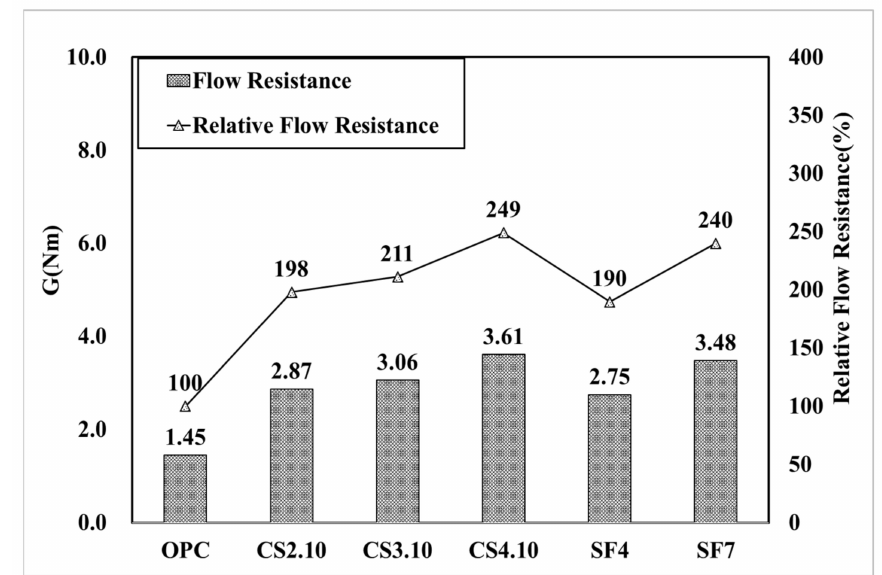
Figure 13. Flow resistance (G) of the mixing